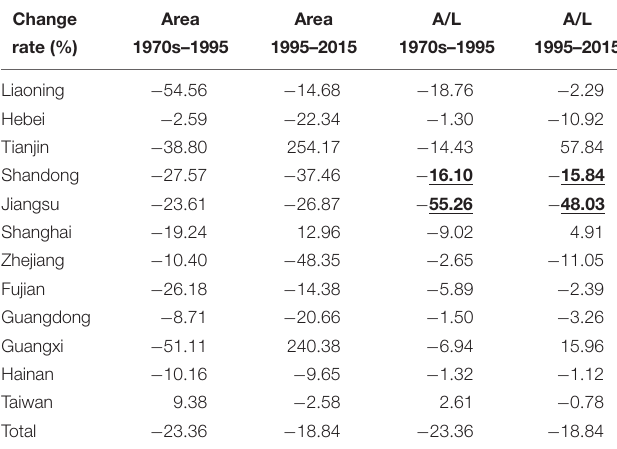
TABLE 5 | Change rate of the area and A/L of intertidal wetland. Change Area Area A/L A/L